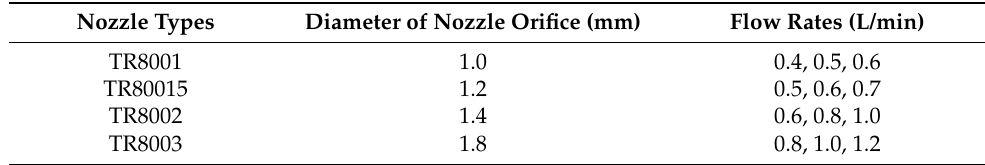
Table 1. Information of hollow-cone